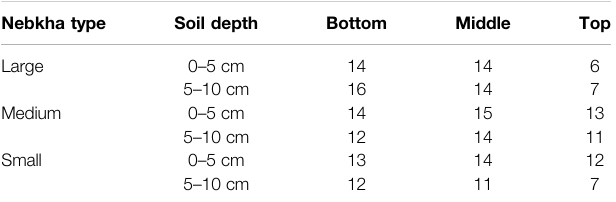
TABLE 3 | Vertical distribution of soil seed banks (number of species) in Nitraria tangutorum nebkhas. Nebkha type Soil depth Bottom